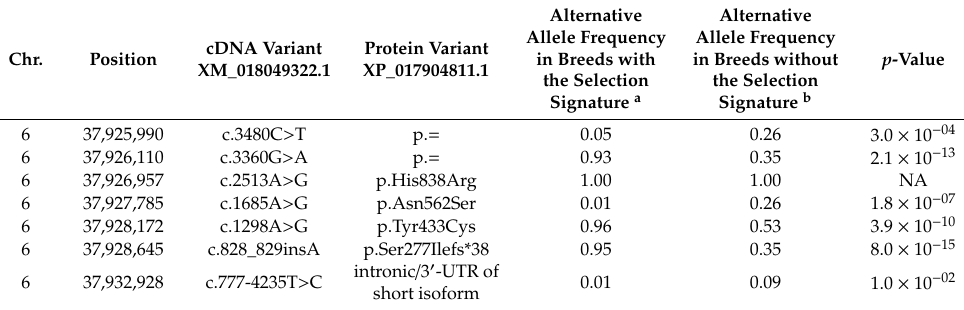
Table 4. Genotype phenotype association of selected SNVs in the LCORL